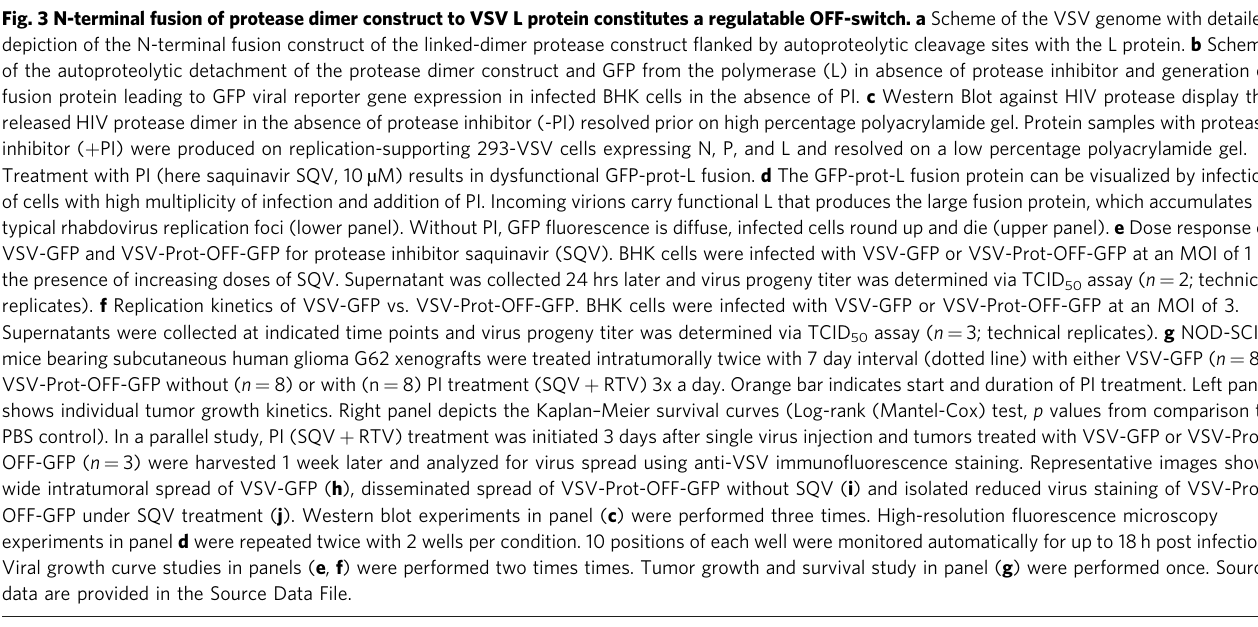
data are provided in the Source Data